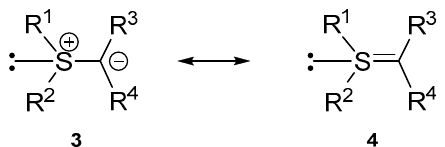
Figure 2. Resonance structures of sulfur ylides 3 and 4 .